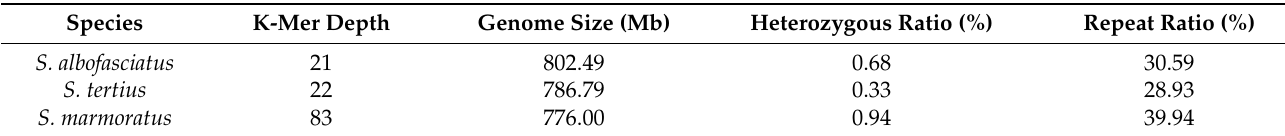
Figure 2. K-mer (19-mer) analysis for estimating the genome size of S. albofasciatus ( A ), S. tertius ( B ), and S. marmoratus ( C ). The X -axis is depth and the Y -axis is the proportion that represents the frequency at that depth. Table 2. Statistics of 17-mer analysis.